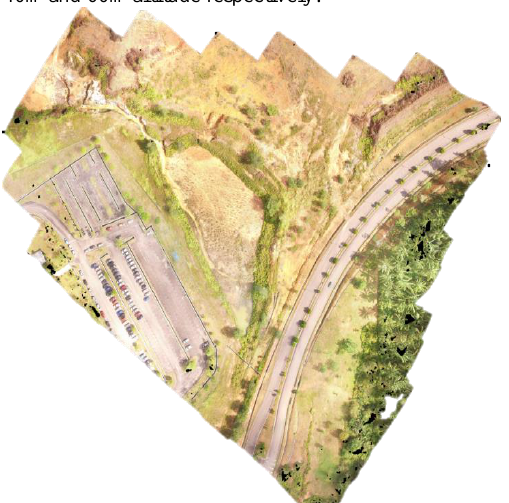
Figure 13. Orthophoto Generated at 60m Altitude